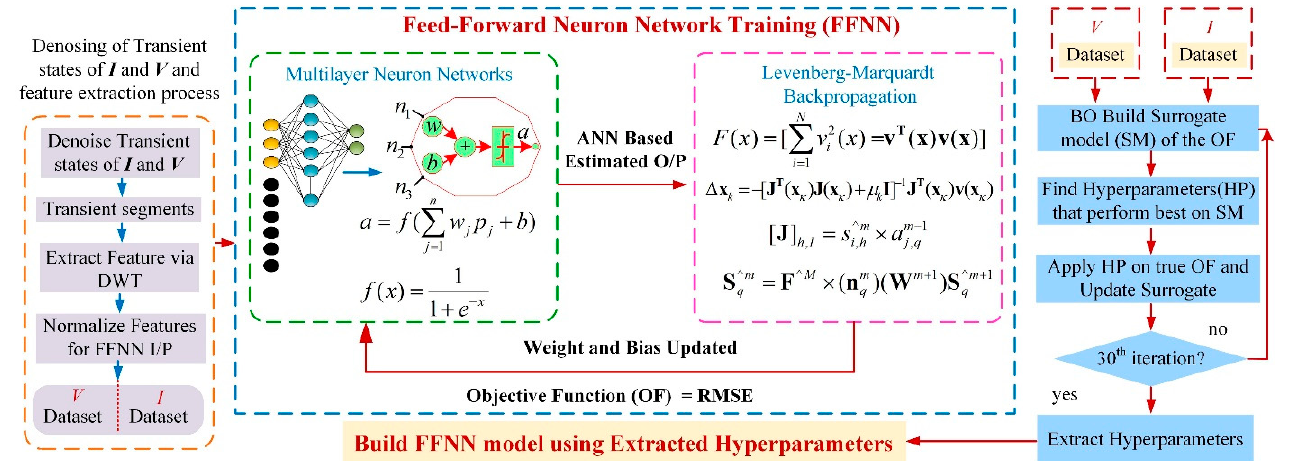
Figure 1. Proposed architecture.